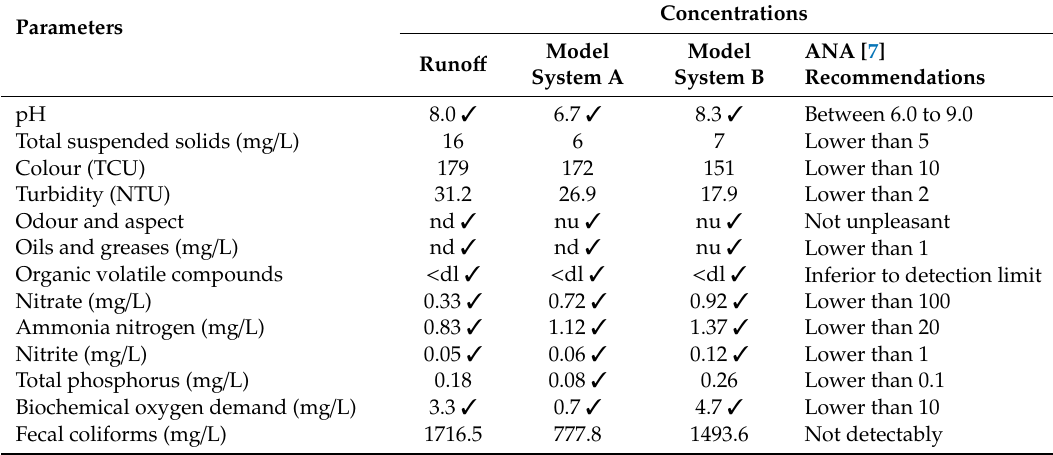
Table 4. Results of water parameter concentrations and limits